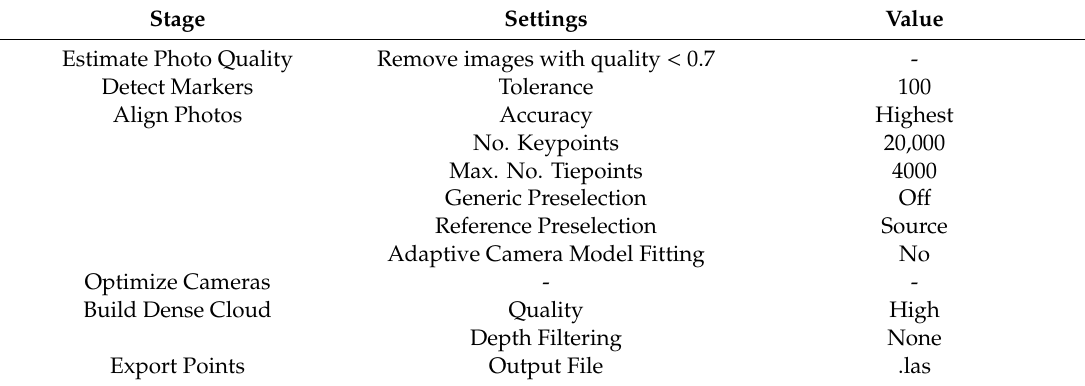
Table 2. The settings we used in Agisoft Metashape in this study. For details on these settings, please consult the Agisoft Metashape Manual